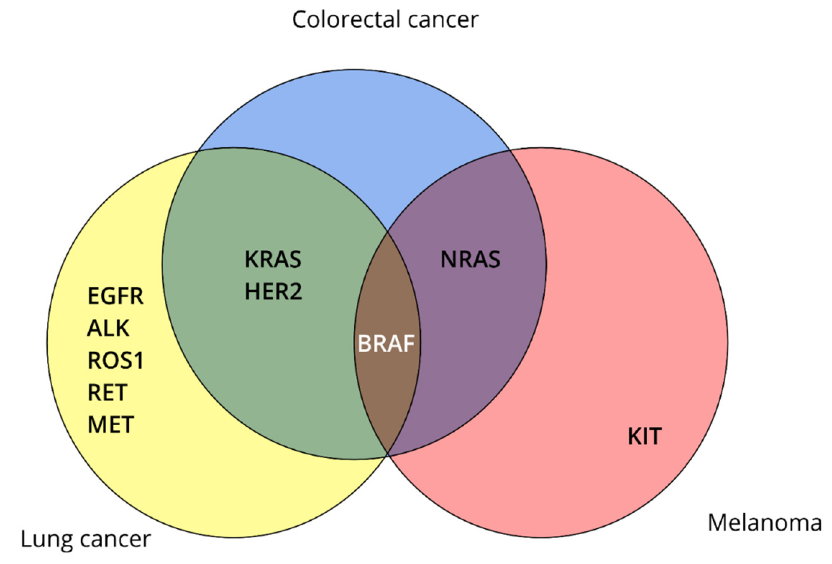
Figure 2. Common predictive mutations in major cancer types. Some mutation tests are more or less organ-specific, while other DNA assays are helpful in several categories of cancer